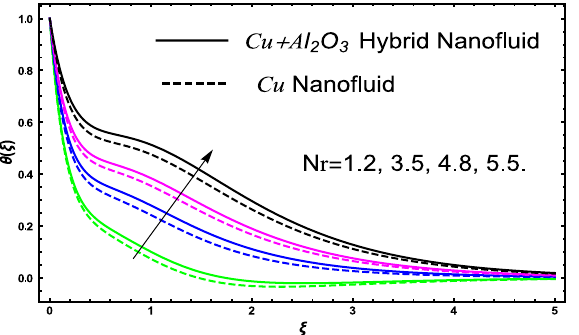
Figure 7. The fluctuation in temperature θ(ξ) profile versus accelerated values of Nr .